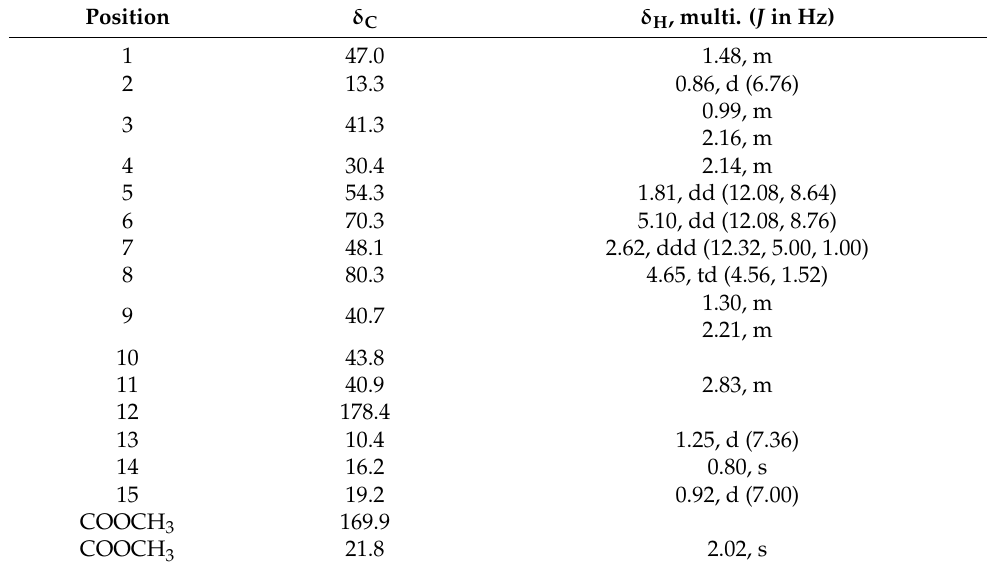
Table 1. 1 H-NMR (400 MHz) and 13 C-NMR (100 MHz) of 1 (CDCl3, δ in